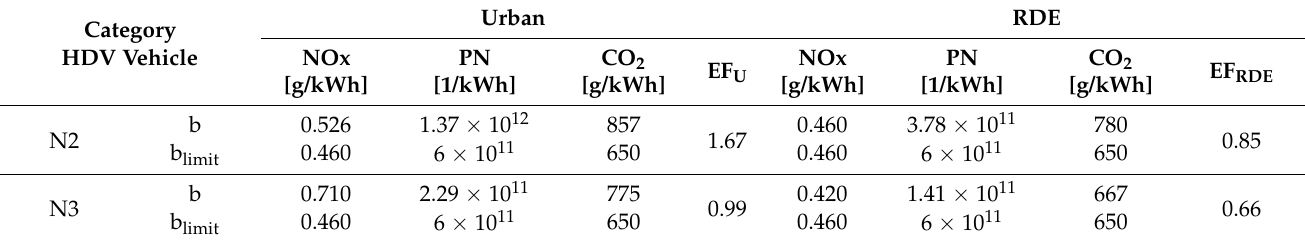
Table A5. Emission factors (EF) for heavy-duty vehicles (health option, α NOx = 0.45, α PN = 0.45, α CO2 = 0.1). Category HDV